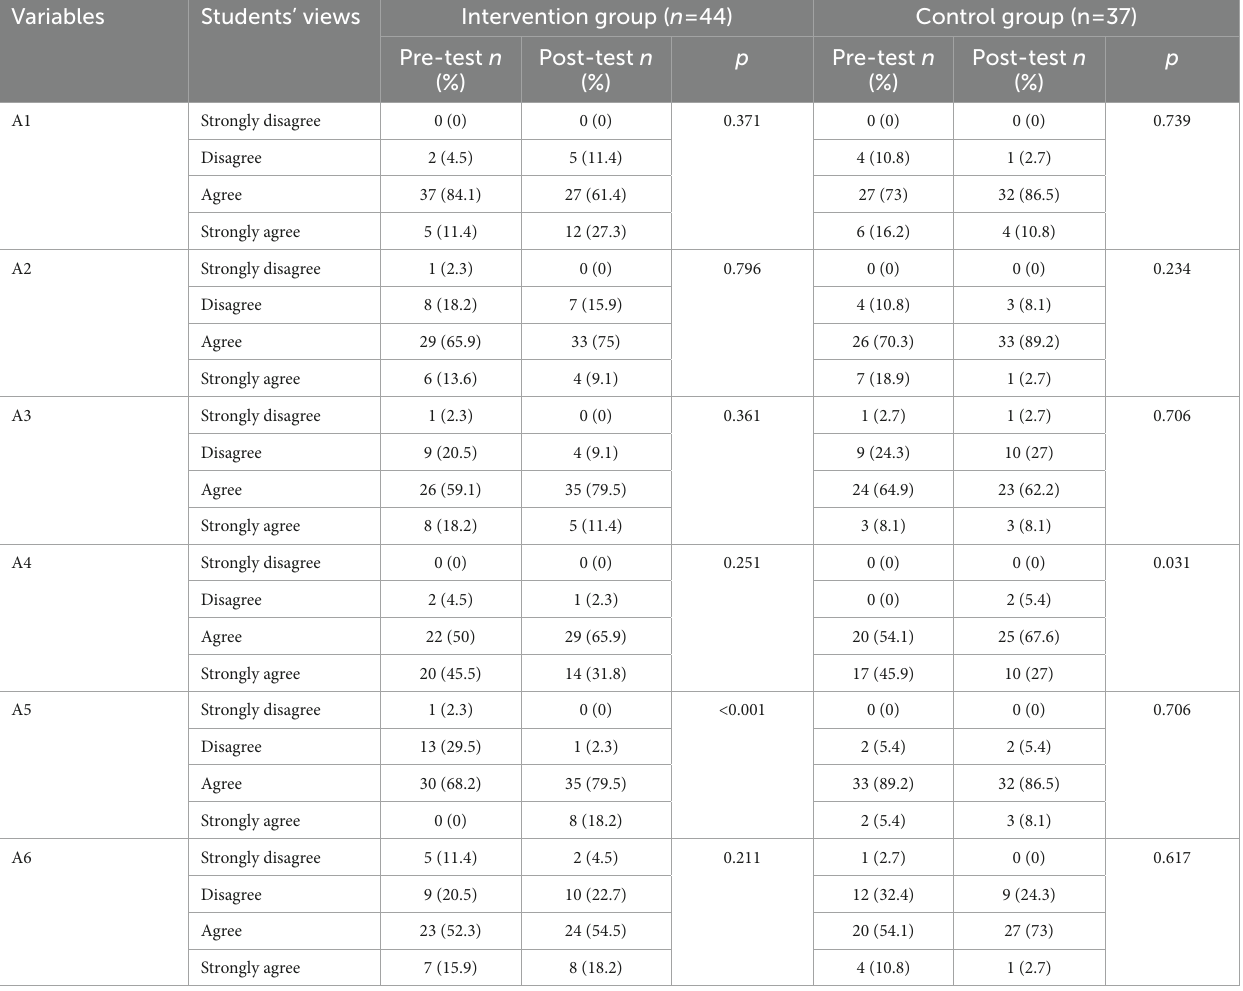
TABLE 3 Students’ views on regional cooperation between Hong Kong and mainland China before the intervention (pre-test) and after the intervention (post-test) among the intervention group and control group.